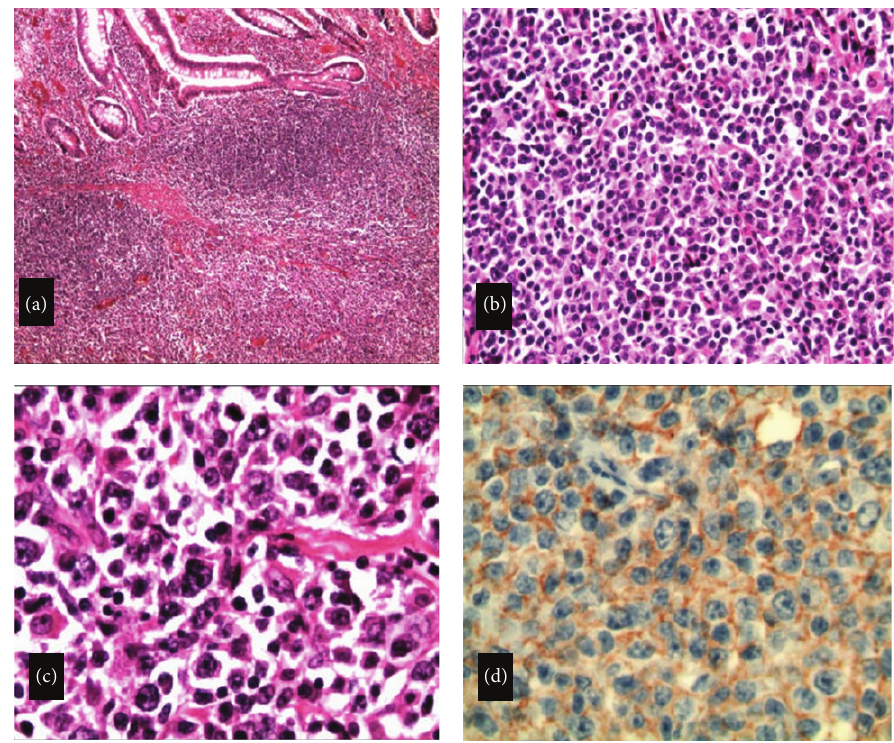
Figure 3: Diffuse large B-cell lymphoma (DLBCL): the tumor composed of diffuse infiltration of large lymphoid cells in all wall layers of the affected terminal ileum. (a) Staining with hematoxylin-eosin, magnification × 40. (b) Staining with hematoxylin-eosin, magnification × 200. (c) Staining with hematoxylin-eosin, magnification × 400. (d) Immunoperoxidase staining for CD20, magnification ×